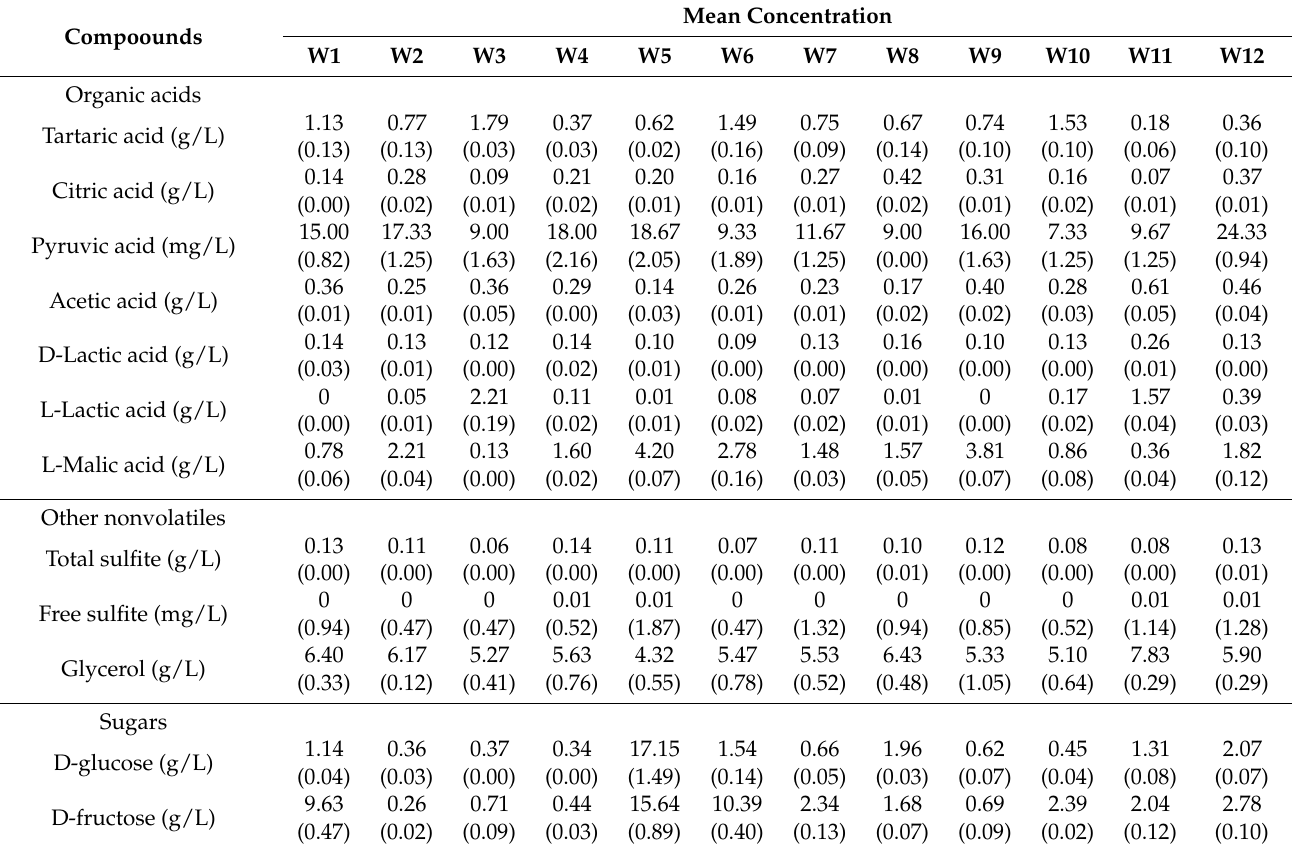
Table 3. Concentration of organic acid and other nonvolatile compounds of white wine samples 1